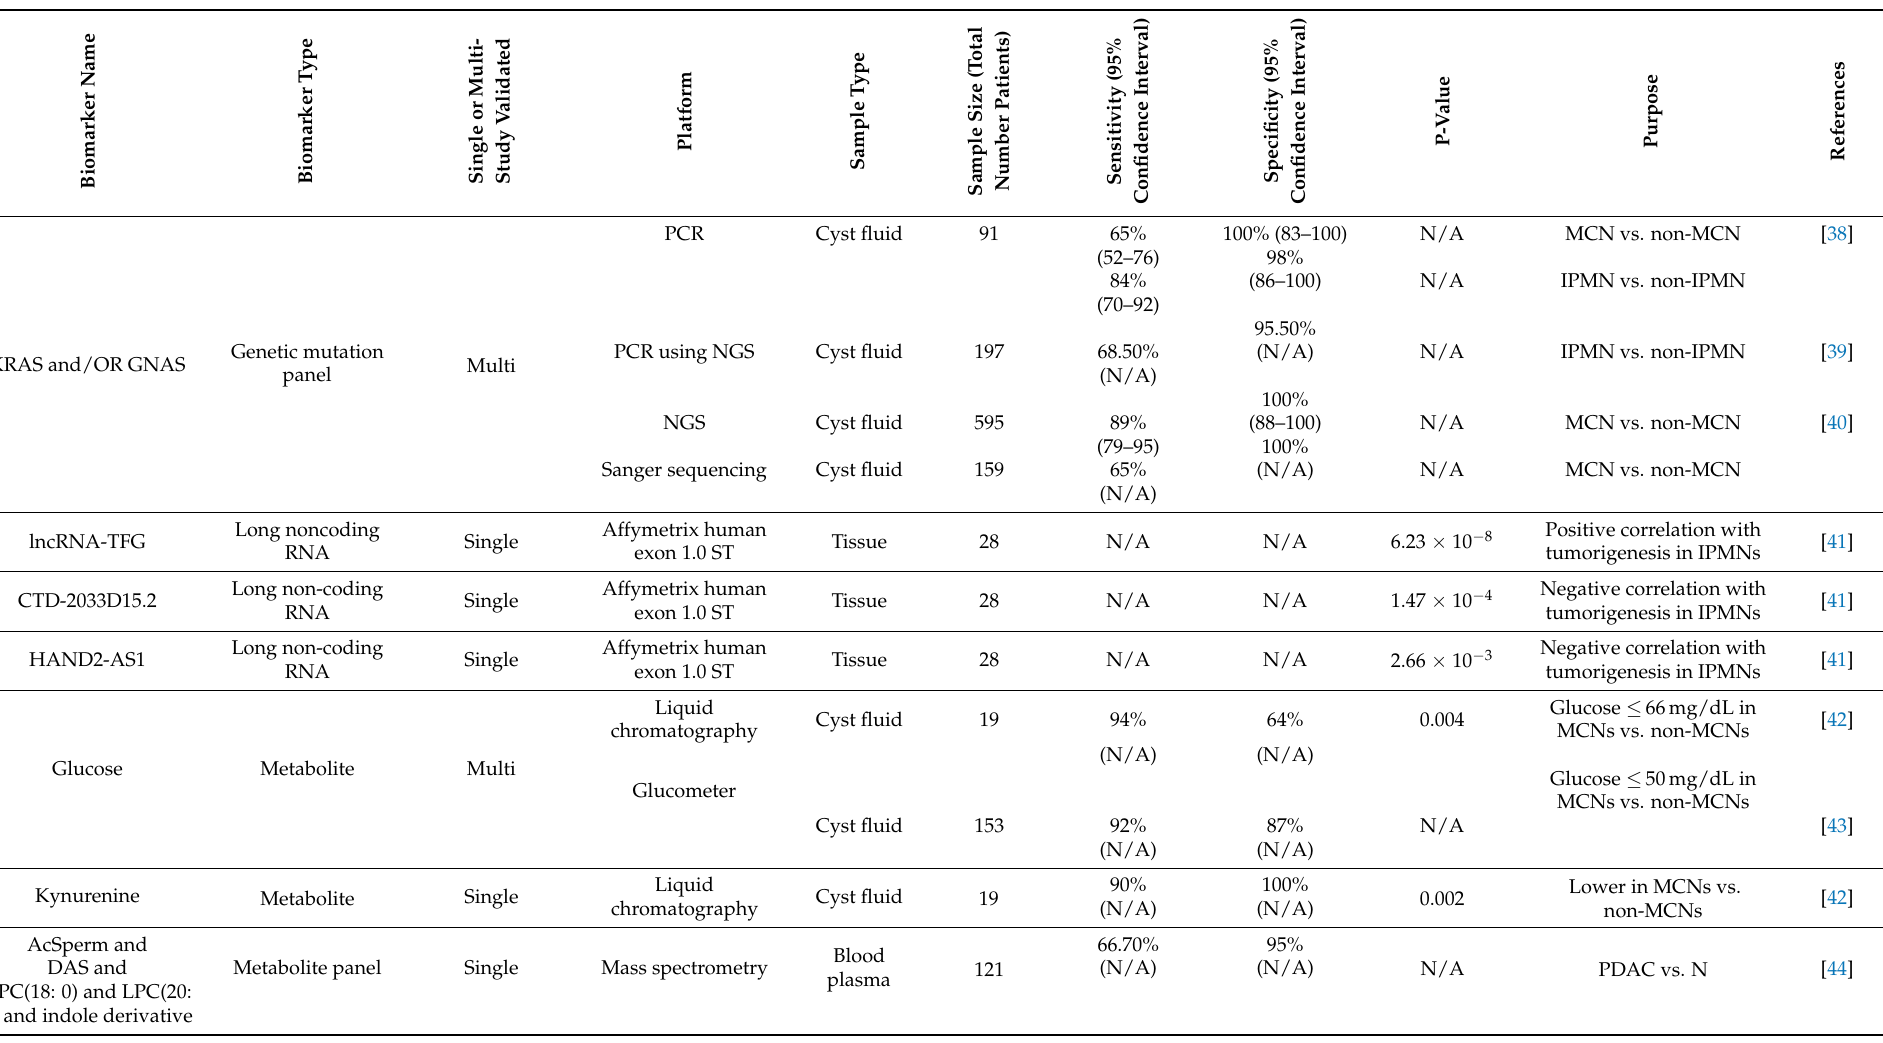
Table 1. Overview of biomarkers in PC and PCLs that have been validated in an independent